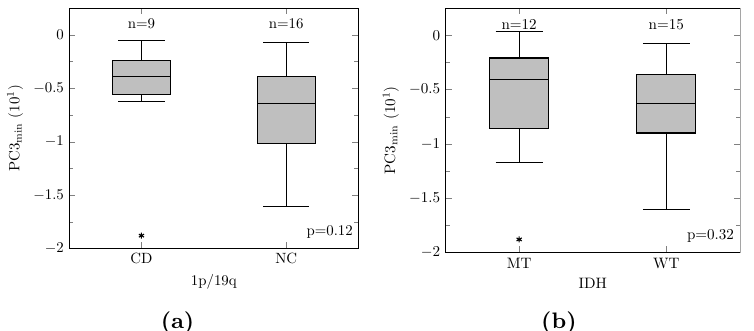
Figure A6. Boxplots of the minimum PC3 values within the BTV (horizontal line: median, box: interquartile range, whiskers: ± 1.5 interquartile range, *: outliers) grouped by 1p/19q codeletion status ( a ) and IDH mutation status ( b ). The associated p -values were obtained by means of